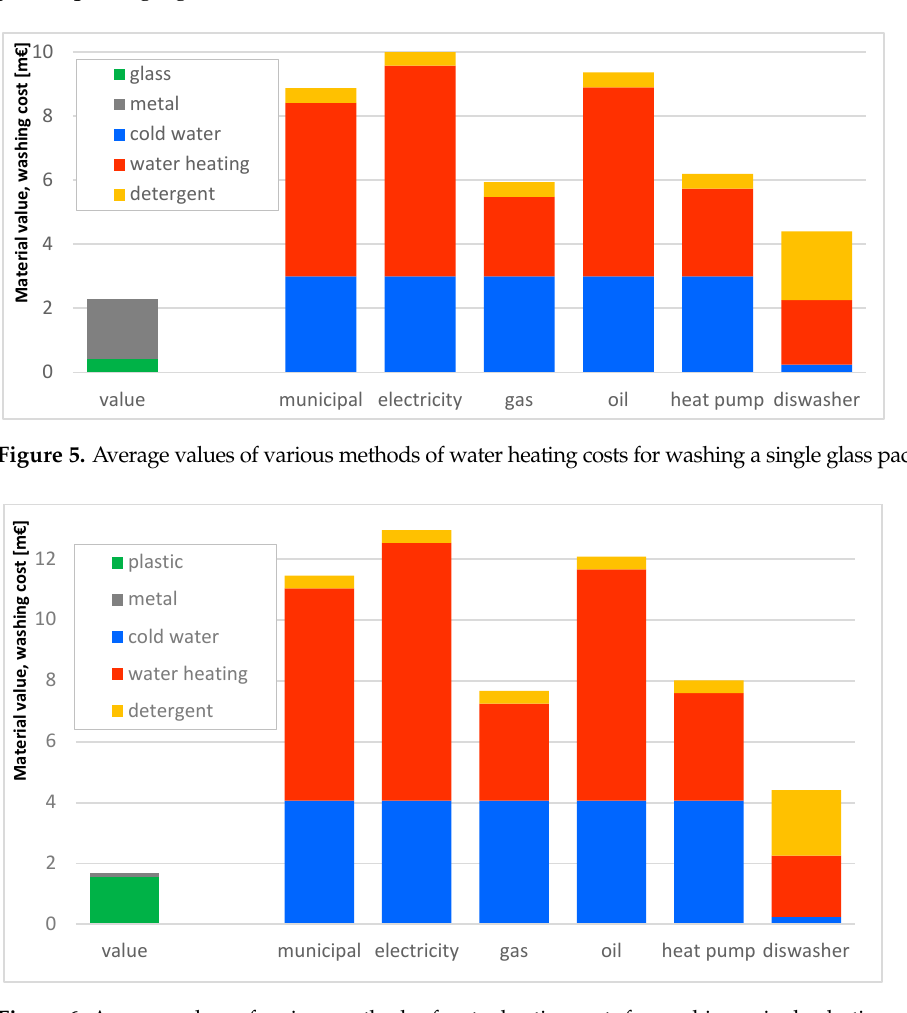
Figure 6. Average values of various methods of water heating costs for washing a single plastic packaging.